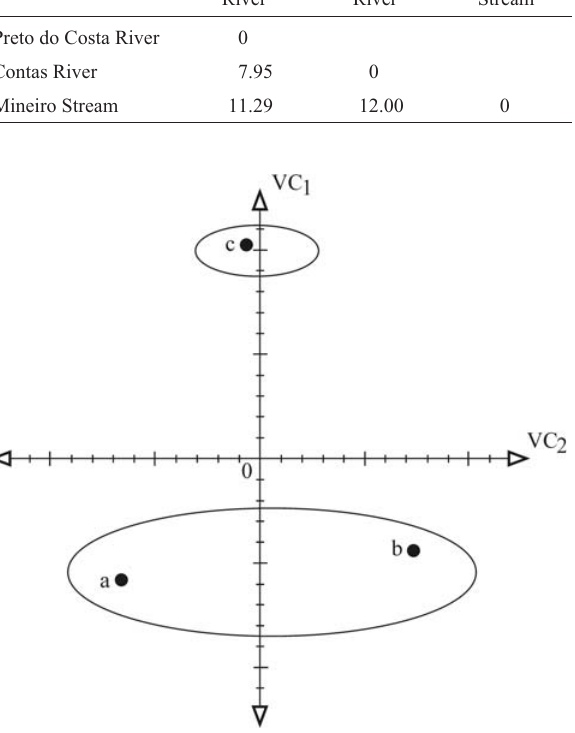
Figure 2 - Graphic dispersal and clustering by Tocher optimization method of three Astyanax fasciatus populations in relation to the first two canonic variables: (a) Contas River, (b) Preto do Costa River, and (c) Mineiro